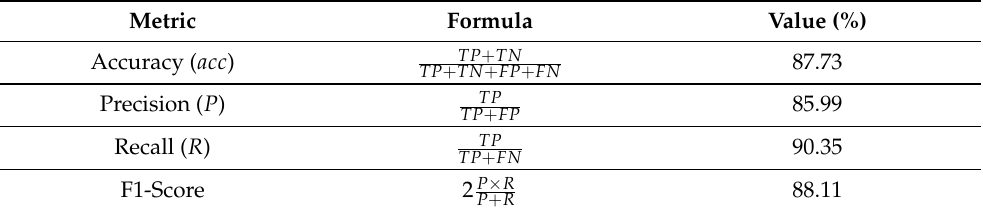
Table 1. Evaluation metrics of the proposed model for the test set.